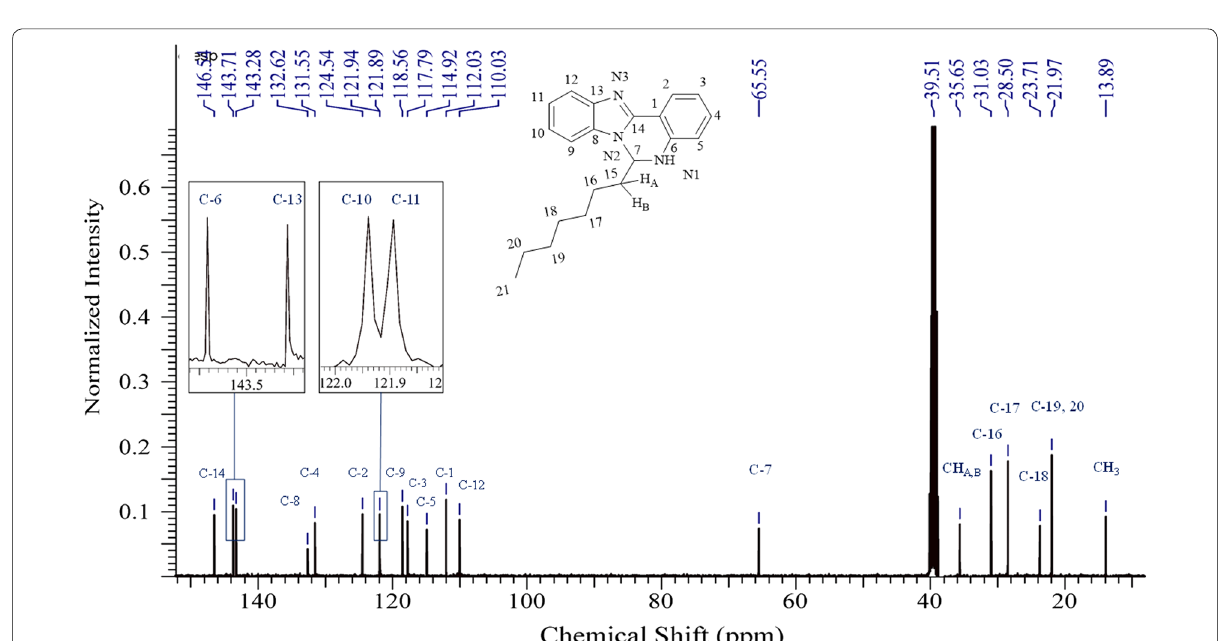
Fig. 3 13 C-NMR of